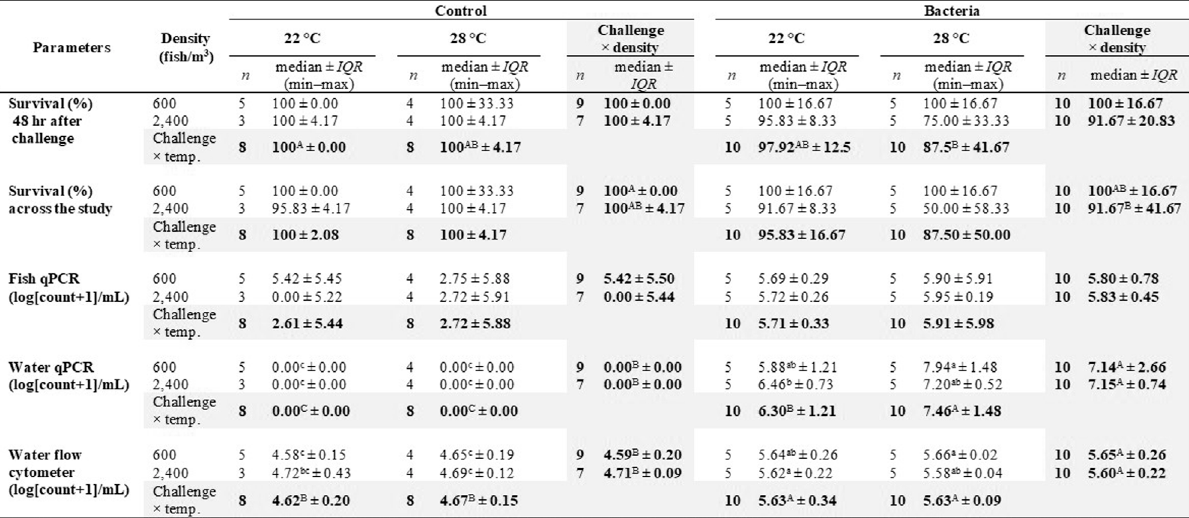
TABLE 3 | Median, interquartile range ( IQR ), minimum measurement (min), and maximum measurement (max) of survival % and log (count of F. covae + 1)/ml of fi sh qPCR, water qPCR, and fl ow cytometer bacterial count in water for challenge-temperature-density treatment groups ( n =